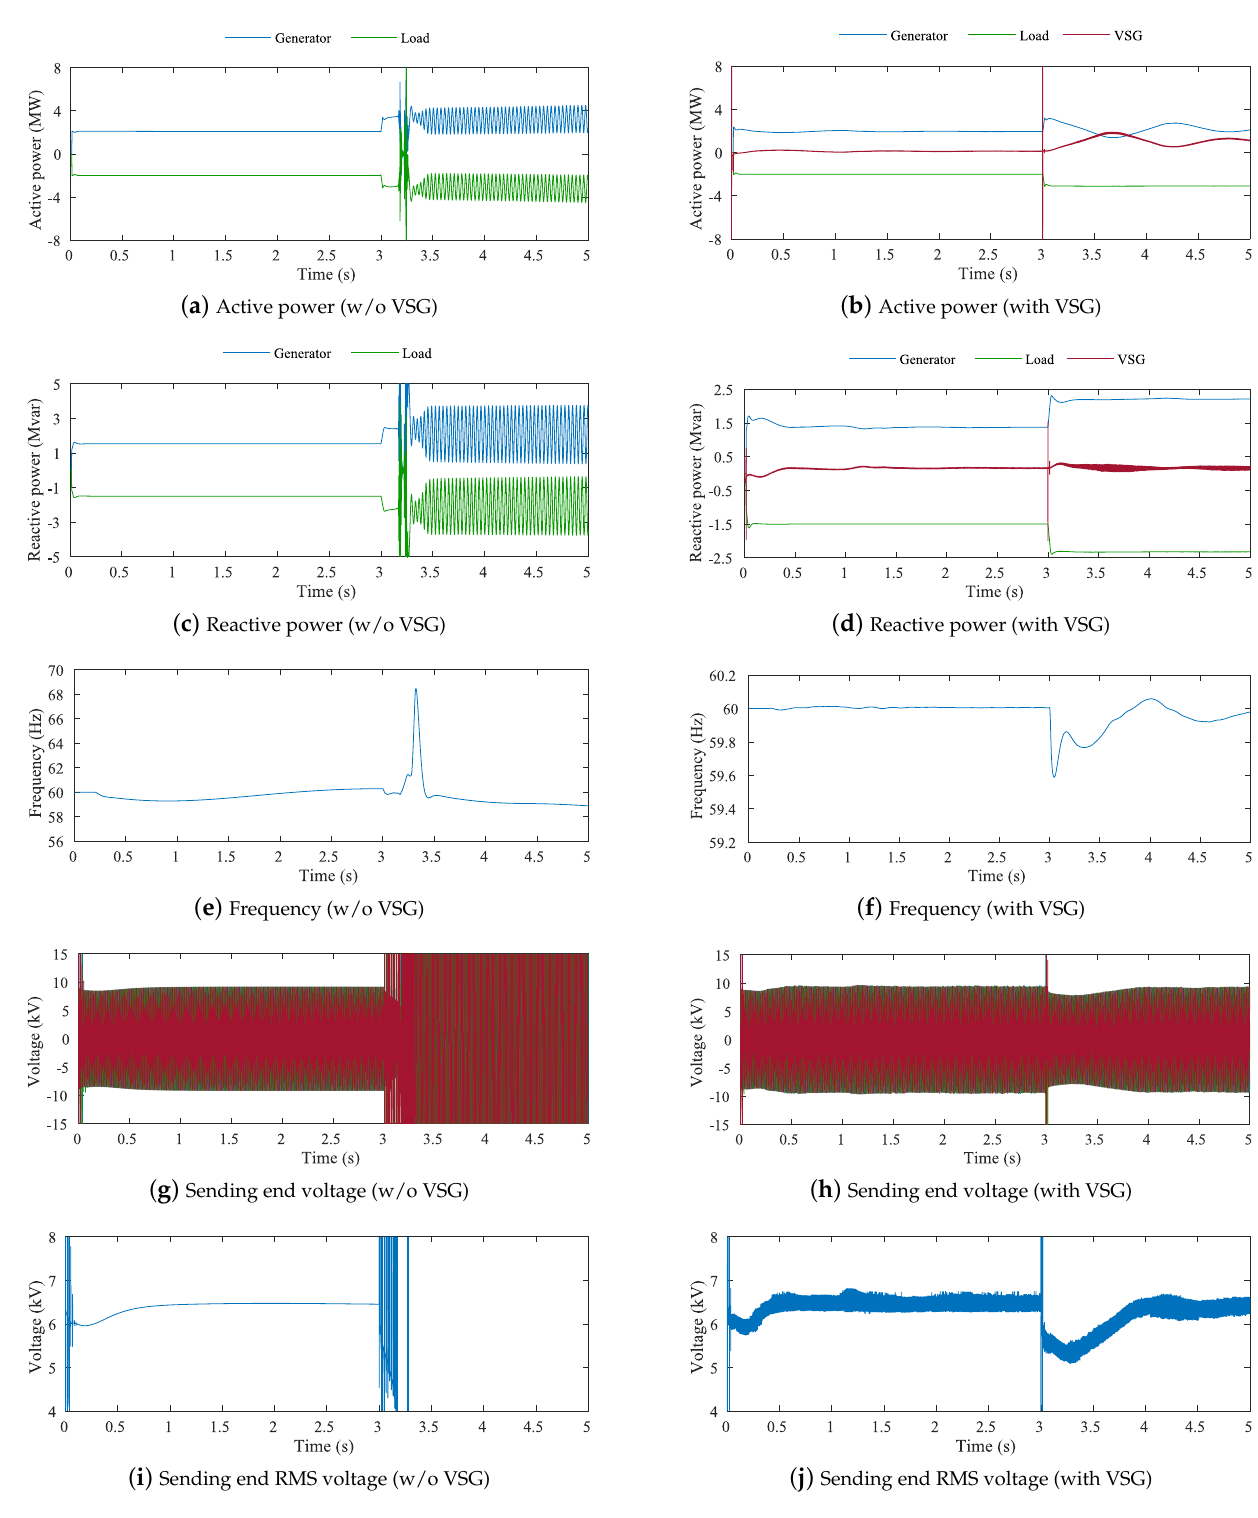
Figure 13. Simulation results of Case 1.3 with/without